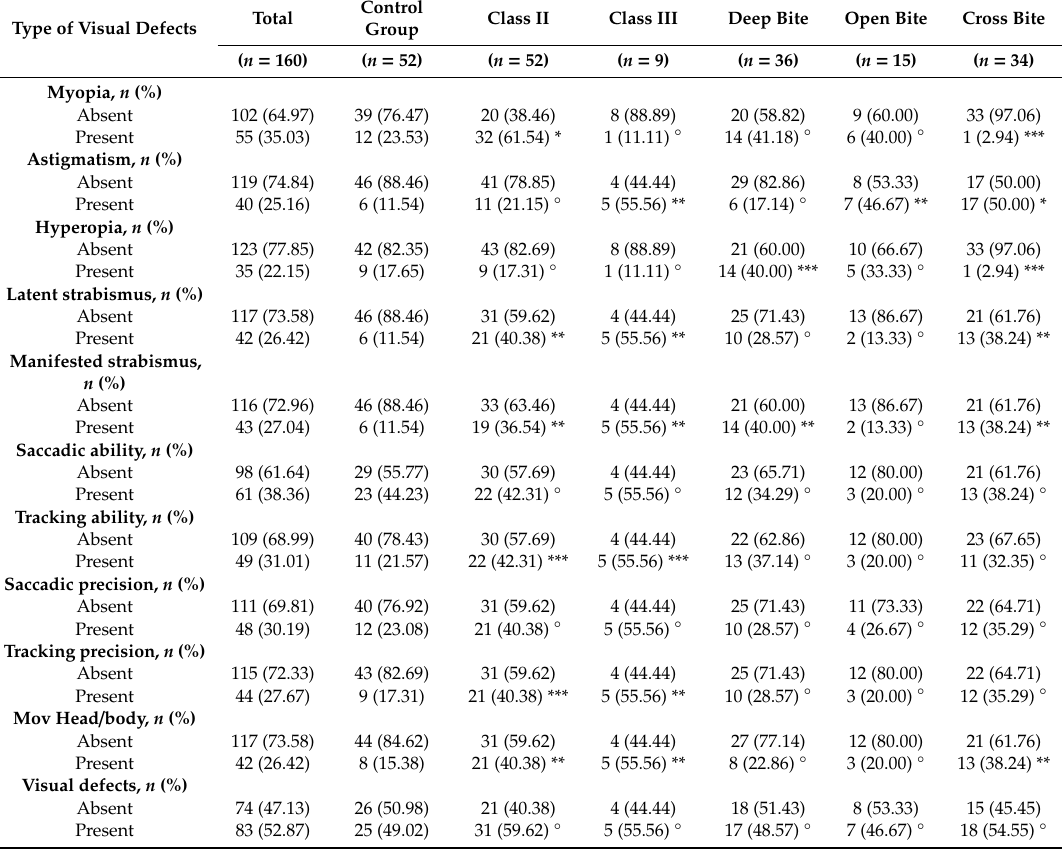
Table 1. Frequency distributions of vision defects, stratified for orthodontic